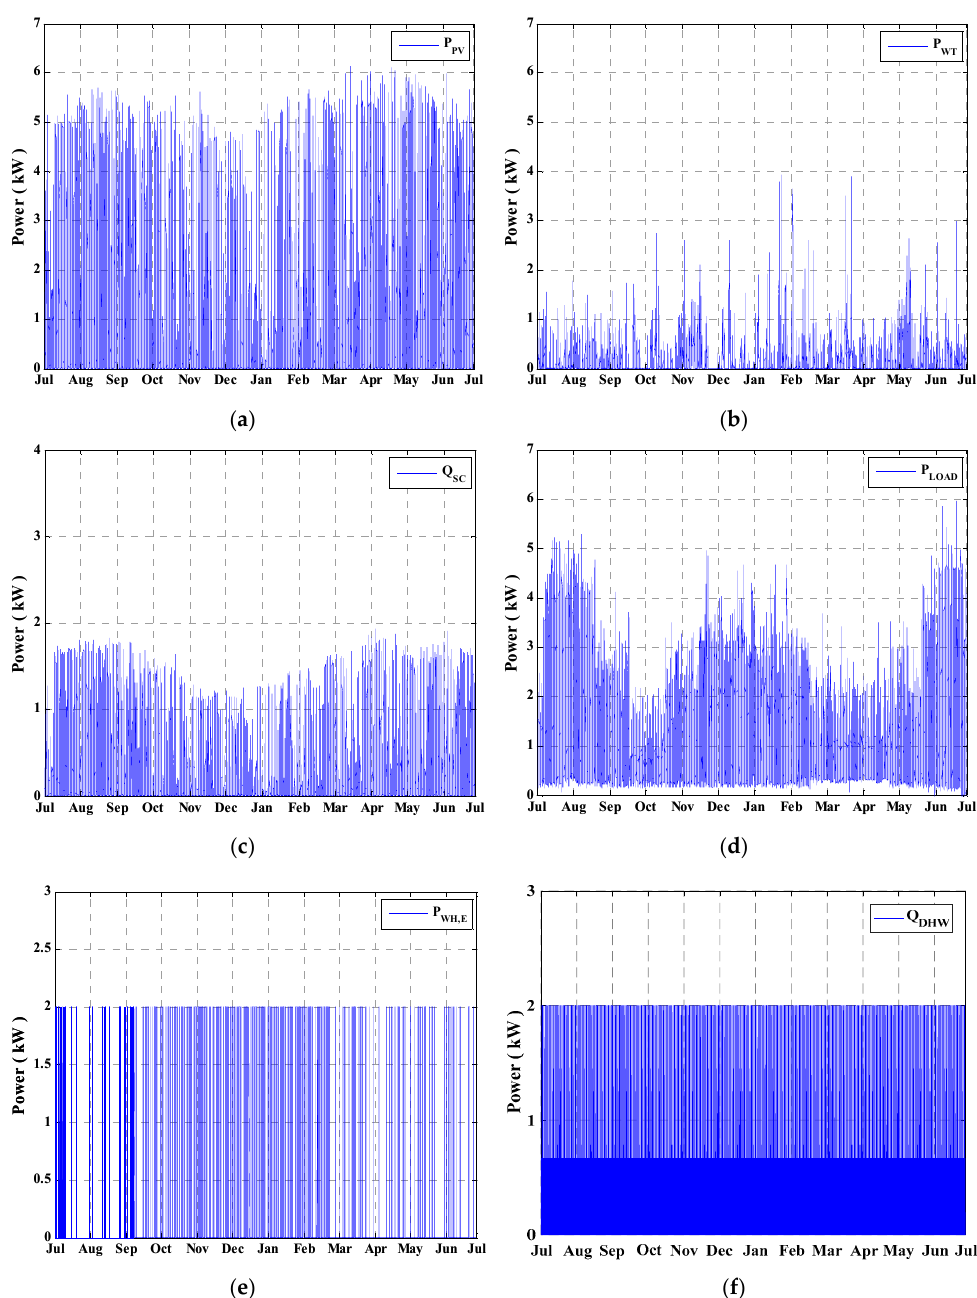
Figure 2. Microgrid power profiles: ( a ) Photovoltaic power, ( b ) wind turbine power, ( c ) solar thermal collector power, ( d ) domestic load demand, ( e ) electric water heater power, and ( f ) domestic hot water equivalent power.